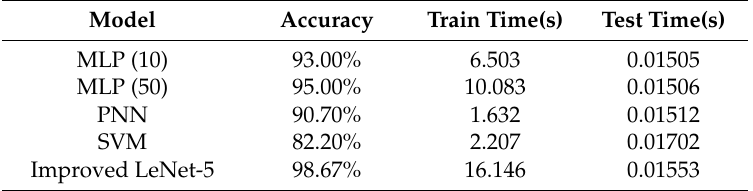
Table 7. Comparison of performances with shallow models tested by untrained original Table 10. Comparison of performances with shallow models tested by untrained original data.